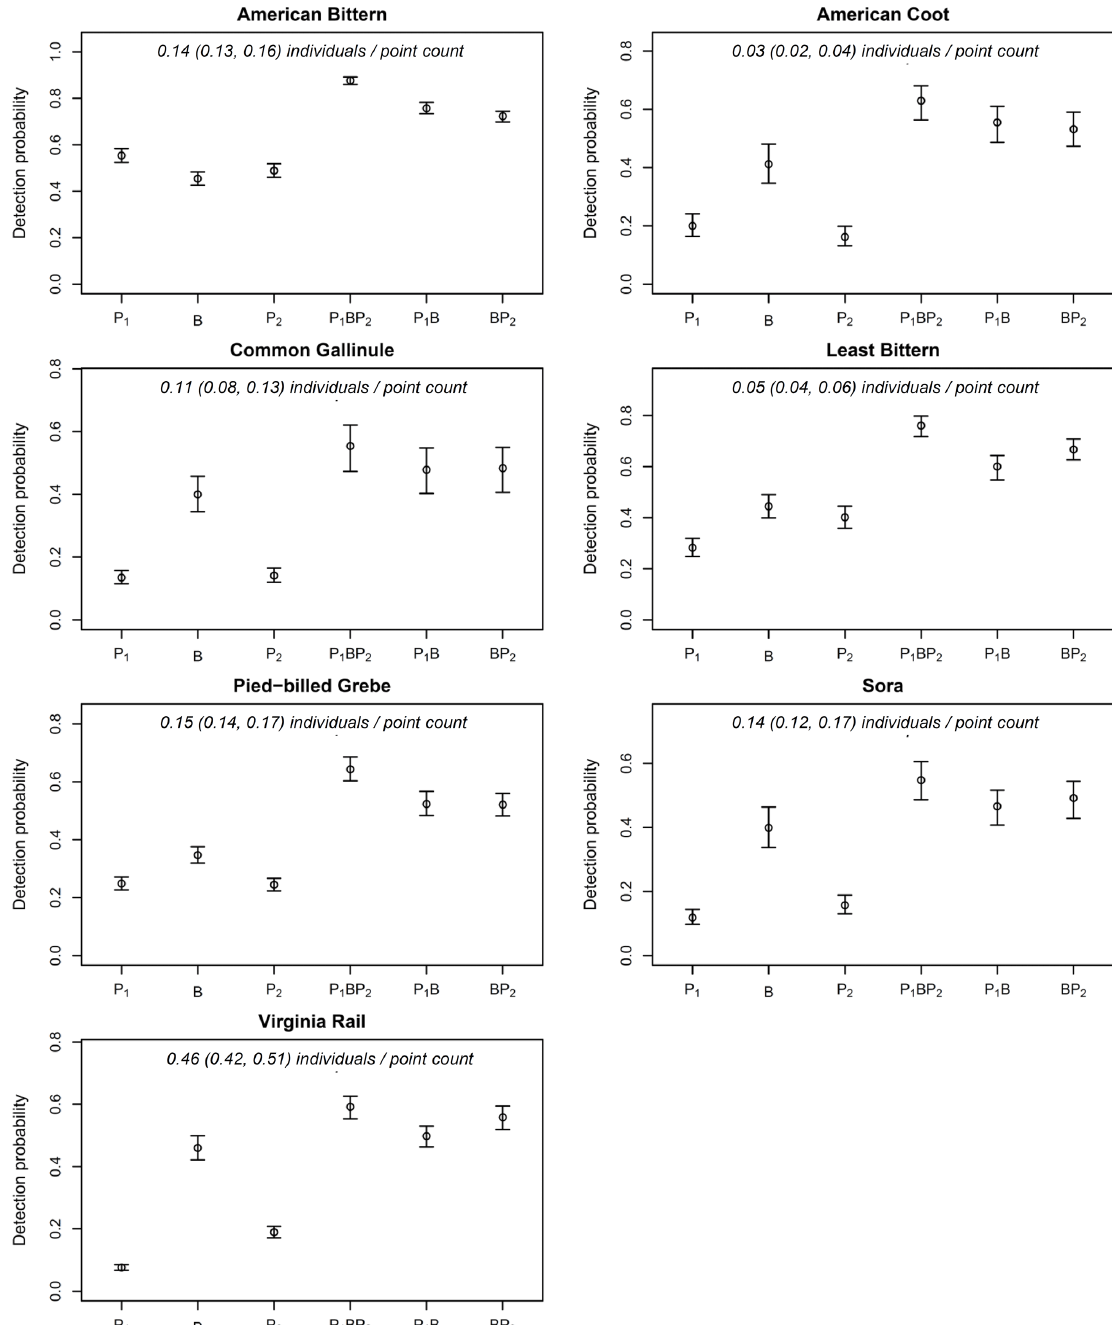
Fig. 4 . Detection probability of individuals of some marsh breeding bird species (± 95% confidence intervals) during various 5-min periods and combinations of consecutive 5-min periods during 23,973 broadcast-assisted 15-min point counts throughout the Great Lakes–St. Lawrence region, 2008–2016. P = first 5-min passive observation period consisting of min 1–5, B = 5-min broadcast 1 period consisting of min 6–10, P = second 5-min passive observation period consisting of min 11–15, P B = first 10 min consisting 2 1 of min 1–10, BP = second 10 min consisting of min 6–15, P BP = entire 15-min point count consisting of min 1–15. See Fig. 2 for 2 1 2 a schematic depiction of the periods and combinations of consecutive periods. Predicted abundance (lower, upper 95% confidence interval) from binomial N -mixture models also shown at the top of each panel for each